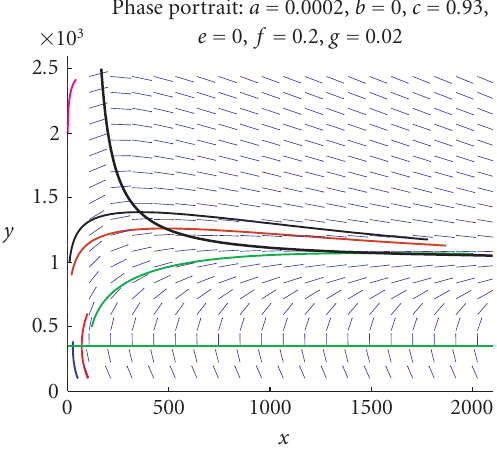
Figure 3.2. Phase plot showing the flow field and the asymptotic behavior of the dynamical system, when c < 1, f + c > 1. Trajectories starting from di ff erent initial conditions are shown in color. The solid black line is the nullcline axy − f x − gy = 0; the solid green line shows the nullcline ay = 1 − c . The phase particle has a negative x -component of velocity below this green line, indicating a drop in the terrorist population, and a positive component above it. Notice that the terrorist population asymptotically increases constantly while the S population again reaches a steady state given by y = f/a =